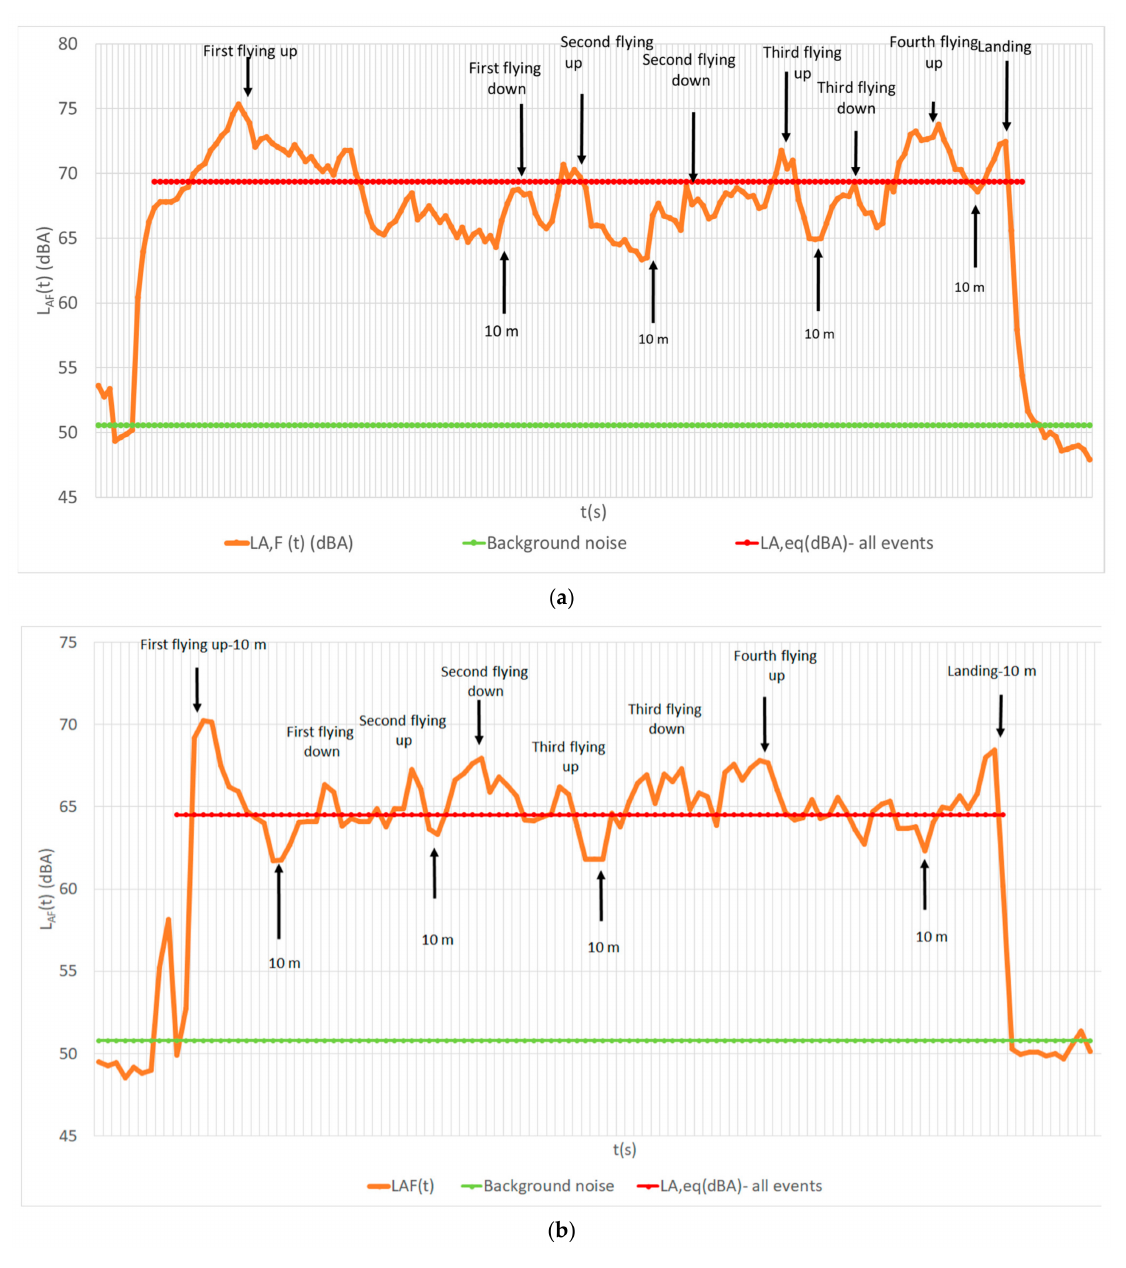
Figure 3. The measurement signals for flying up and down procedures for: ( a ) hexarotor; ( b )